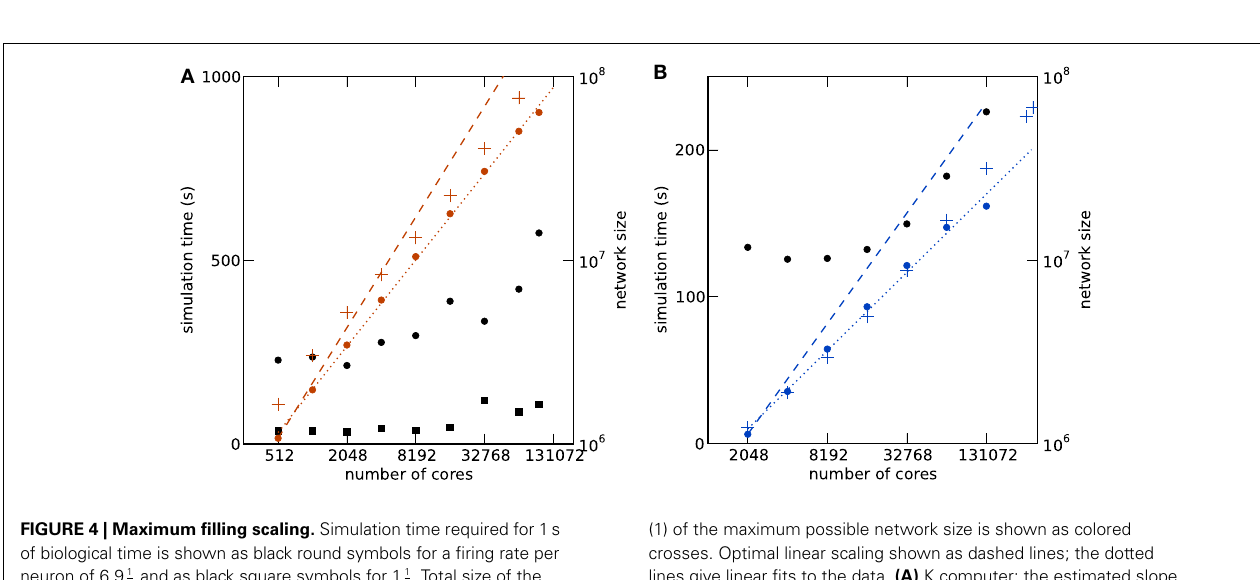
FIGURE 3 | Maximum filling scaling. The network size (number of neurons) is chosen so that the simulation consumes all available memory.The affordable number of neurons per core (black round symbols) decreases with increasing number of cores to keep the total memory consumption close to the usable maximum.The dotted lines give linear fits to the data.The memory consumption at different stages of the simulation (colored round symbols: after allocating the neurons, colored crosses: after establishing the synapses, colored triangles: after running the simulation) show the memory